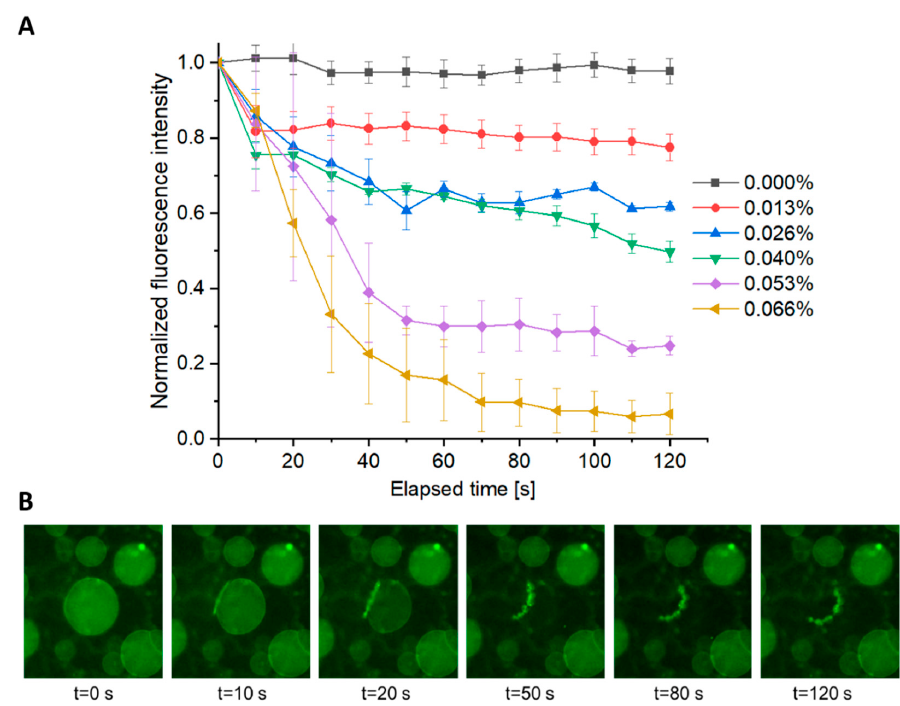
Figure 6. Effect of AuNP concentration on encapsulant release. ( A ) The fluorescence intensity inside of an individual vesicle is measured as a function of time following a single 532 nm, fs pulse (144 nJ). Each line represents the fluorescence decay in an ROI (3–4 replicates +/ − SEM) with varying concentrations of AuNPs encapsulated within the polymersome membrane. ( B ) Poration leading to structural instability. A polymersome loaded with 0.066% ( w/v ) AuNPs is subjected to a single fs pulse (144 nJ). Upon irradiation, a large pore can be observed. The vesicle remains intact for 10–20 s following the pulse until the vesicle structure is compromised after approximately 50